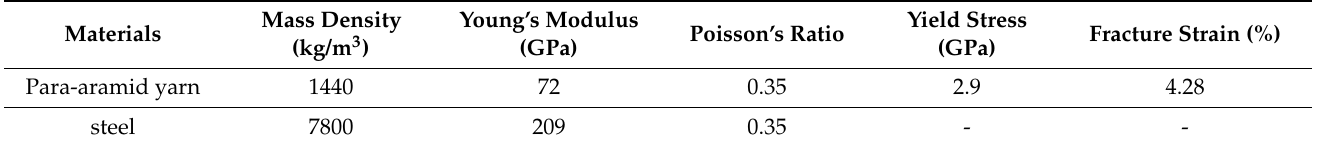
Table 2. Material properties of FE model.